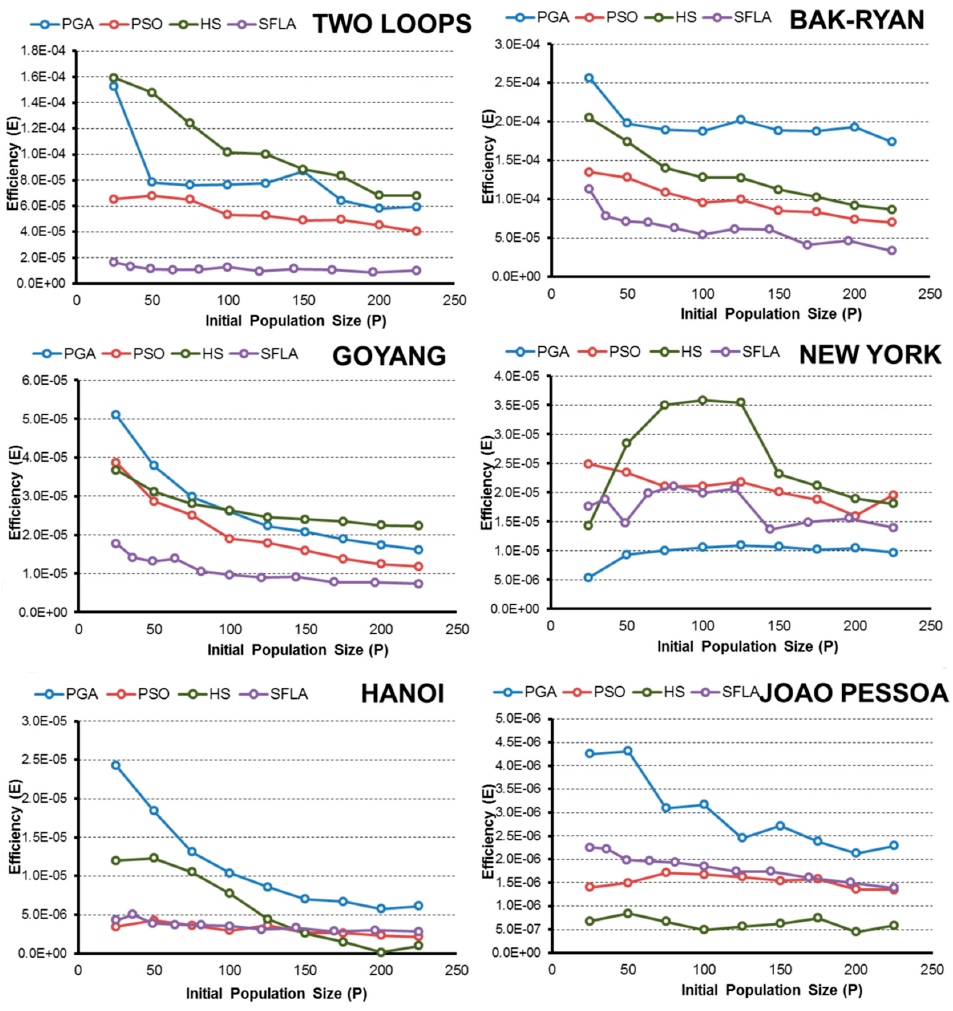
Figure 4. Efficiency of Population-based algorithms in obtaining “good solutions” for the four selected networks.